Question: What form of chart is displayed?
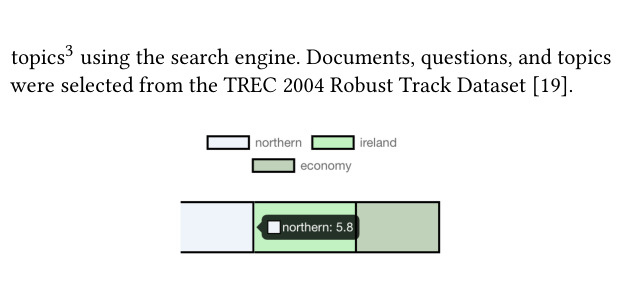
Answer: bar